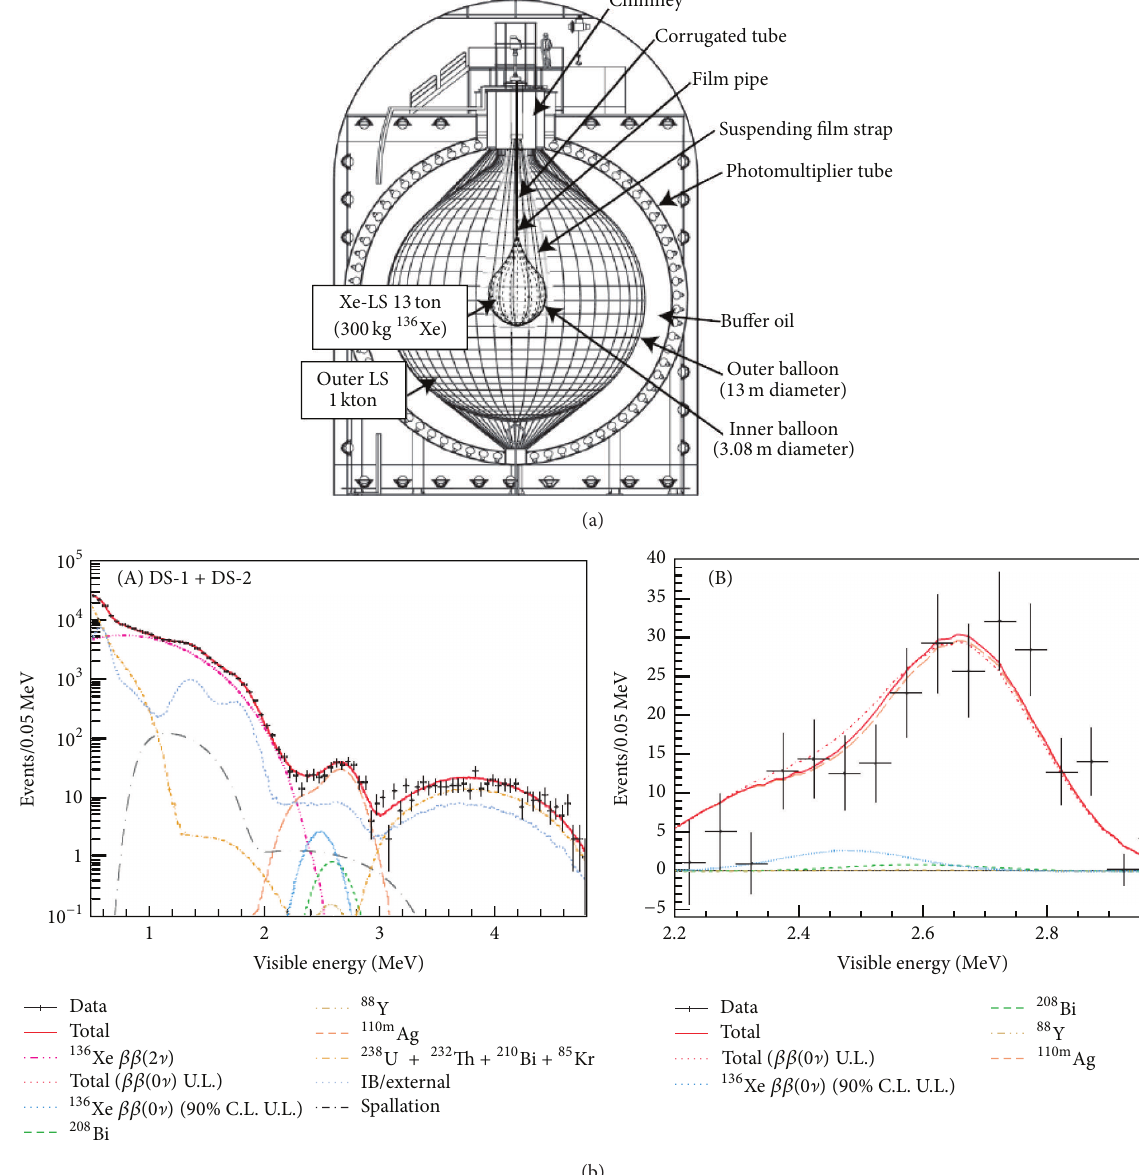
Figure 14: (a) KamLAND-ZEN detector; see text for a description (figure from [132]). (b) KamLAND-ZEN 𝛽𝛽(0 ] ) result (figure from [134]). In the left panel (A) the energy spectrum of selected candidate events together with the best-fit backgrounds and 𝛽𝛽(2 ] ) decays, and the 90% C.L. lower limit for 𝛽𝛽(0 ] ) decays. In the right panel (B), a close-up of (A) 𝛽𝛽(0 ] ) region after subtracting known background contributions.